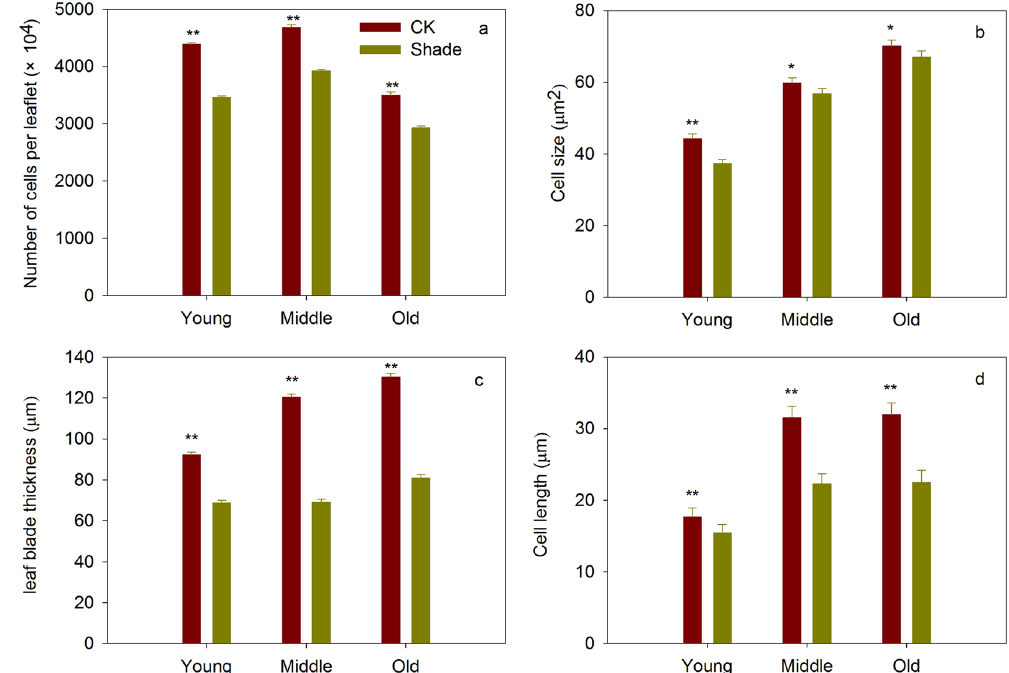
Figure 5. Number of cells per leaflet ( a ), cell size ( b ), leaf blade thickness ( c ) and cell length ( d ) of soybean planted in shade and full sunlight (CK). Values are means ± SD (n = 3). Statistical significance assessed by Duncan’s t-test. * and ** indicates significant at 0.05 and 0.01 probability level,